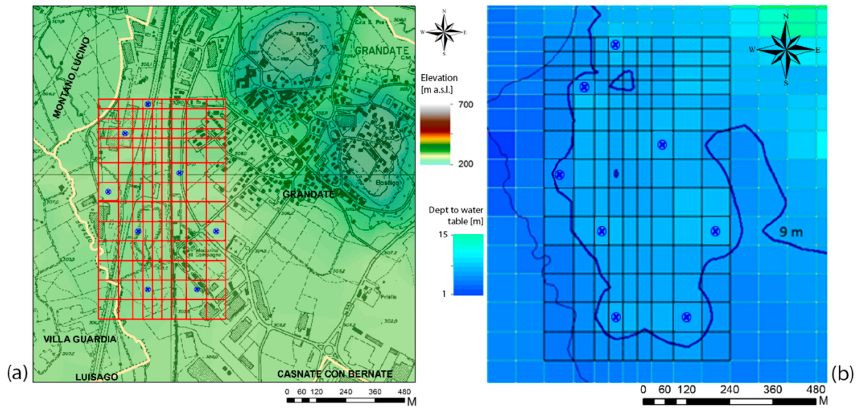
Table 1. General statistics resulting from the model.